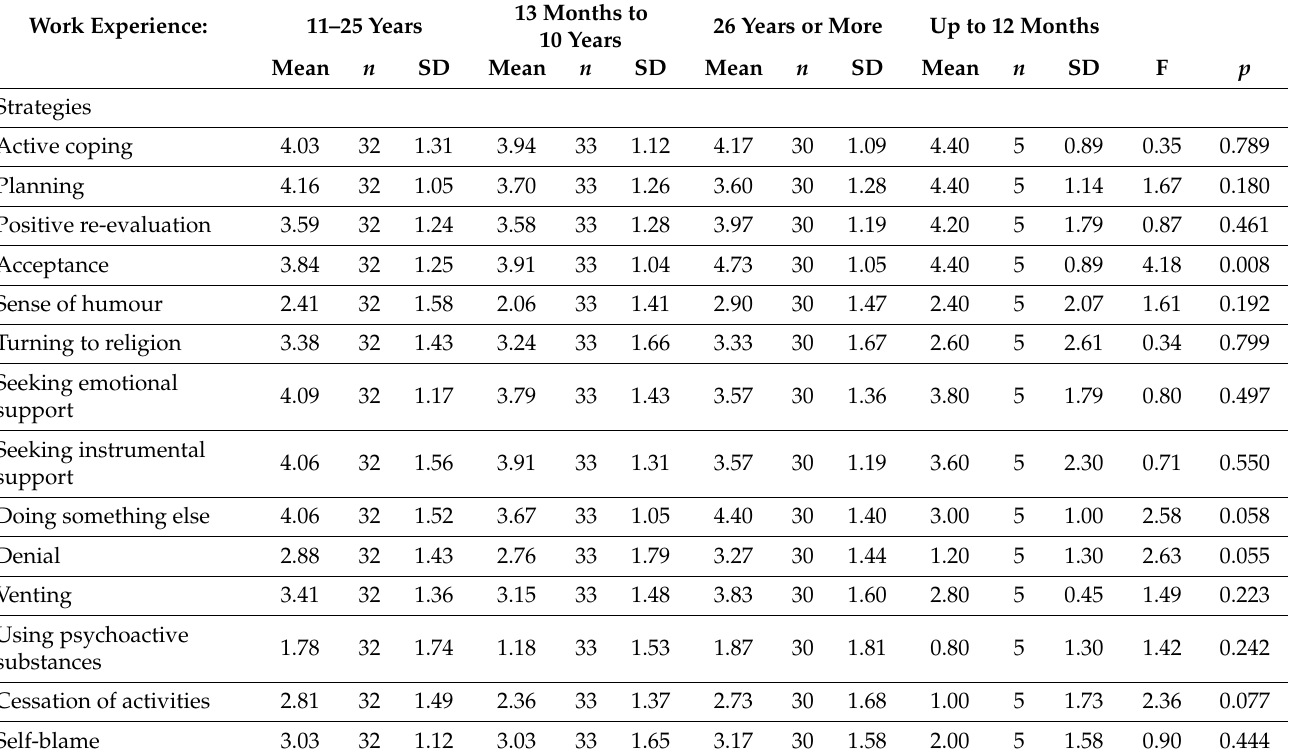
Table 3. Strategies of coping with stress used by nurses depending on their